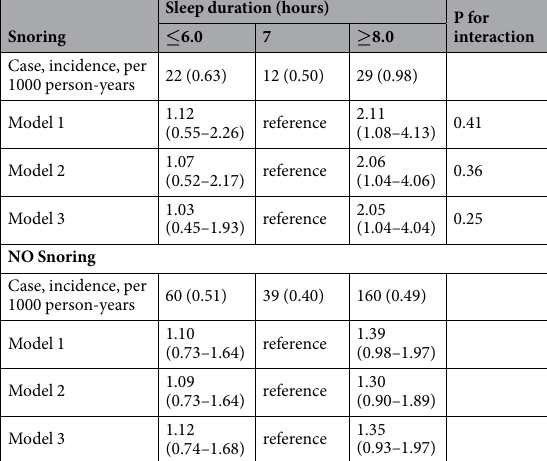
Table 5. Hazard ratios (95% CI) for atrial fibrillation according to sleep duration stratified by snoring status in the Kailuan Study. Model 1: Adjusted for age and sex. Model 2: Adjusted for age, sex, level of education, smoking, alcohol, physical activity, and body mass index. Model 3: Adjusted for variables in Model 2 plus hypertension, diabetes mellitus, dyslipidaemia, myocardial infarction, uric acid and high-sensitivity C-reactive